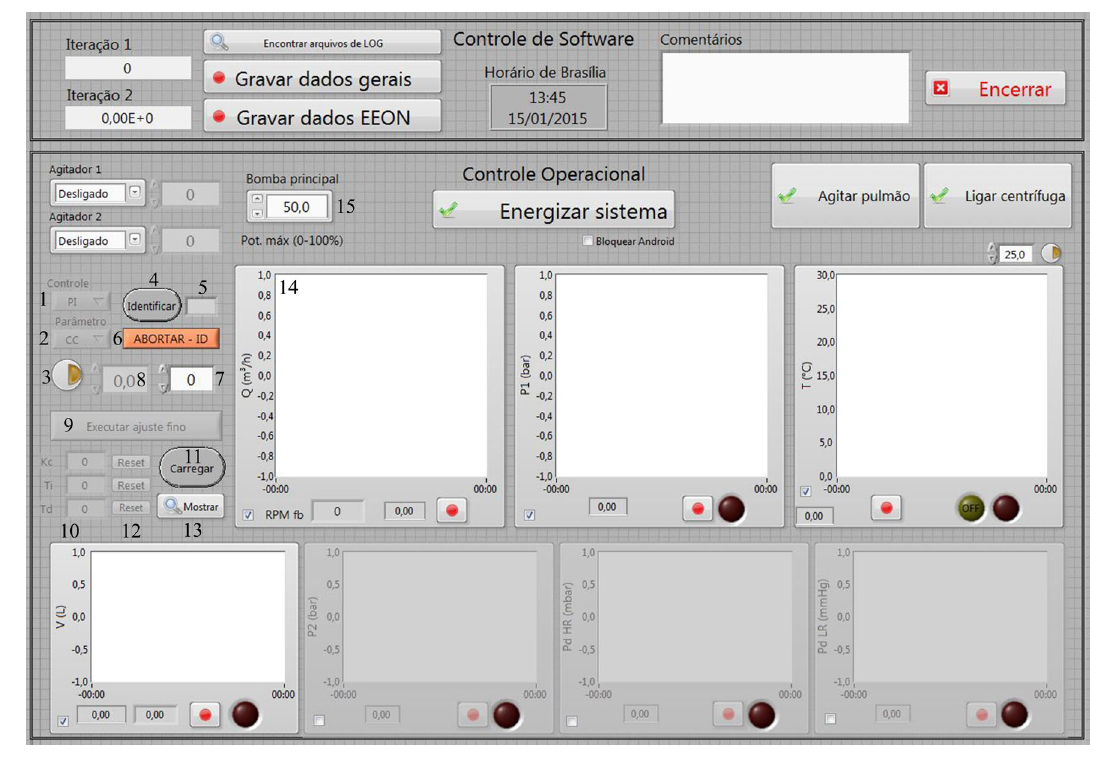
Fig. 4 Photograph of the main HMI